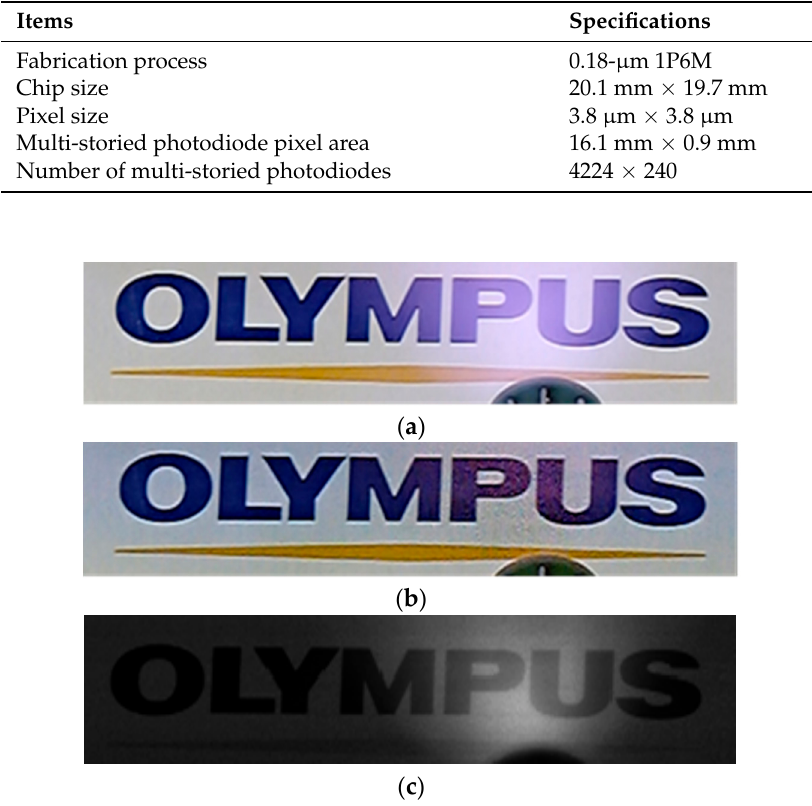
Figure 6. Effect of IR subtraction. ( a ) RGB image without IR subtraction. ( b ) RGB image with IR subtraction. ( c ) NIR image. The object is radiated by an NIR LED, whose wavelength and bandwidth are 900 nm and 60 nm, respectively.